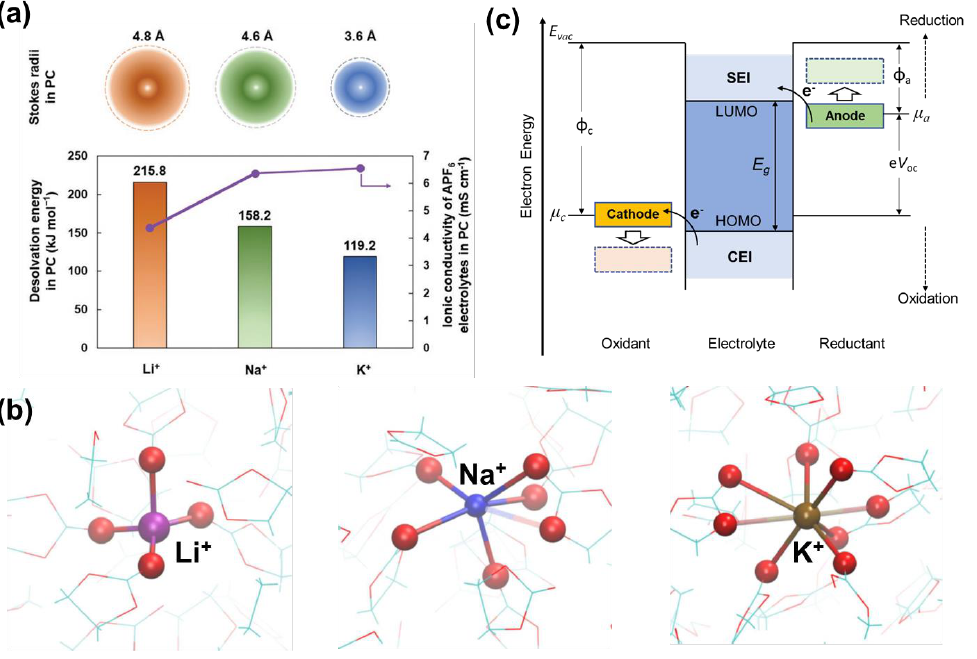
Figure 1. ( a ) Stokes radii, de − solvation energy, and ionic conductivity of APF 6 /PC electrolytes with different cations, i.e., A = Li + , Na + , K + . Reprinted with permission from Ref. [6]. Copyright 2021, John Wiley & Sons. ( b ) Typical solvation structures of Li + , Na + and K + in EC. Reprinted with permission from Ref. [7]. Copyright 2017, American Chemical Society. ( c ) Schemes of open − circuit energy diagram of PIBs ( μ a , μ c : electrochemical potential of anode and cathode and relevant working function φ a , φ c ; E g : electrochemical stability window; E vac , e V oc : vacuum energy level and open circuit voltage). Intensive research on PIBs started in 2015, marked by the demonstration of graphite anode for electrochemically reversible K + storage [8]. Subsequently, in the pursuit of high energy density (as stated by the formula: E (Wh/g) = Q (mAh/g) × voltage (V)), efforts were made towards optimization of electrodes and electrolytes [9,10]. On the negative side, metals with high capacity and appropriately low working voltages were investigated, such as bismuth (Bi), stibium (Sb), and potassium (K) [11 – 13]. On the positive side, high working plateaus over 4.0 V (vs. K + /K, as the standard reference hereafter unless else stated) were proven in polyanionic compounds such as KVPO 4 F and KVOPO 4 [14,15]. Within the configuration of P-DIBs, an even higher working voltage of over 4.5 V could be achieved for graphite cathode, relying on the reversible intercalation of anions [16]. To match the electrodes, electrolytes with wide electrochemical windows (EWs) are highly demanded. As depicted in Figure 1c, the EW of a given electrolyte is determined by the energy difference (E g ) between the lowest unoccupied molecular orbital (LUMO) and the highest occupied molecular orbital (HOMO). In an ideal situation, the thermodynamic stability of the system could be maintained with the electrochemical potential of the anode ( μ a ) below the LUMO and that of the cathode ( μ c ) above HOMO [17,18]. However, in prac- tice, traditional carbonates usually suffer from restrained windows, leaving three major formidable challenges for electrolyte systems. First, the electrolyte will be oxidized and reduced on the cathode and anode side, respectively, for the first few cycles of a cell, along with the formation of passivation layers on both sides, namely, the solid electrolyte inter- phase (SEI) for the anode and the cathode electrolyte interphase (CEI) for the cathode, to